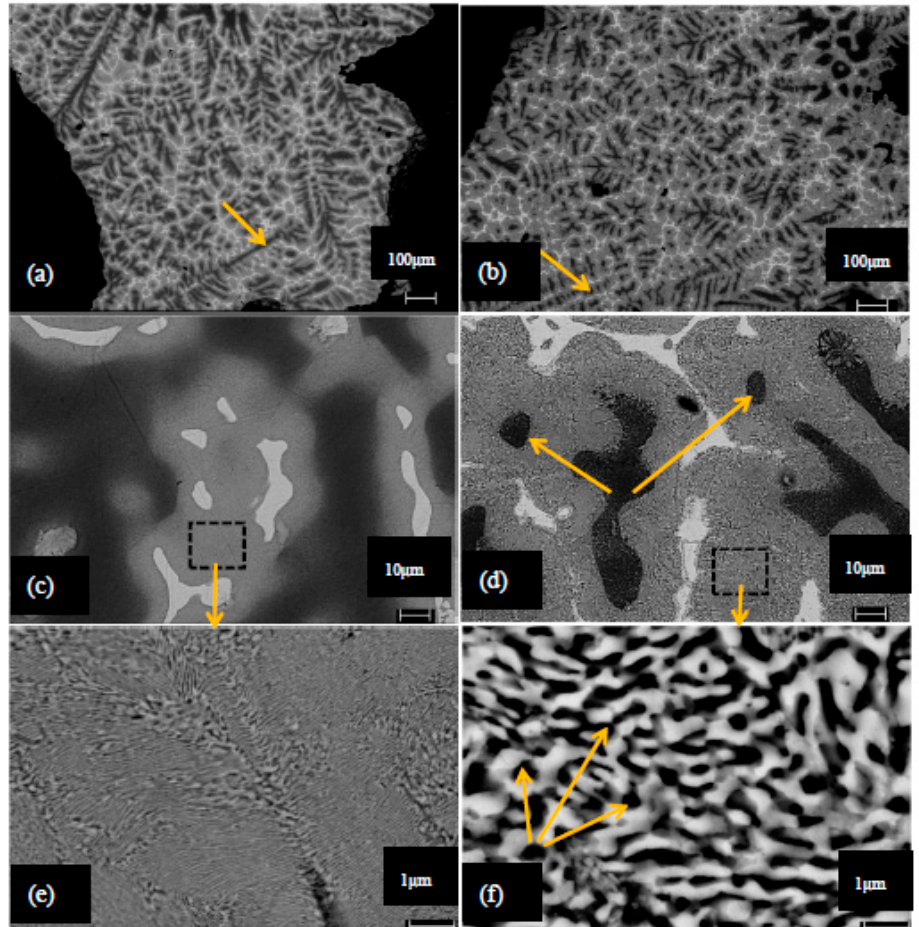
Figure 5. SEM images of cell walls in ( a ) as-cast and ( b ) heat-treated ZA27 syntactic foam. Magnified images of different phases in the cell walls in ( c ) as-cast and ( d ) heat-treated. Magnified SEM images of